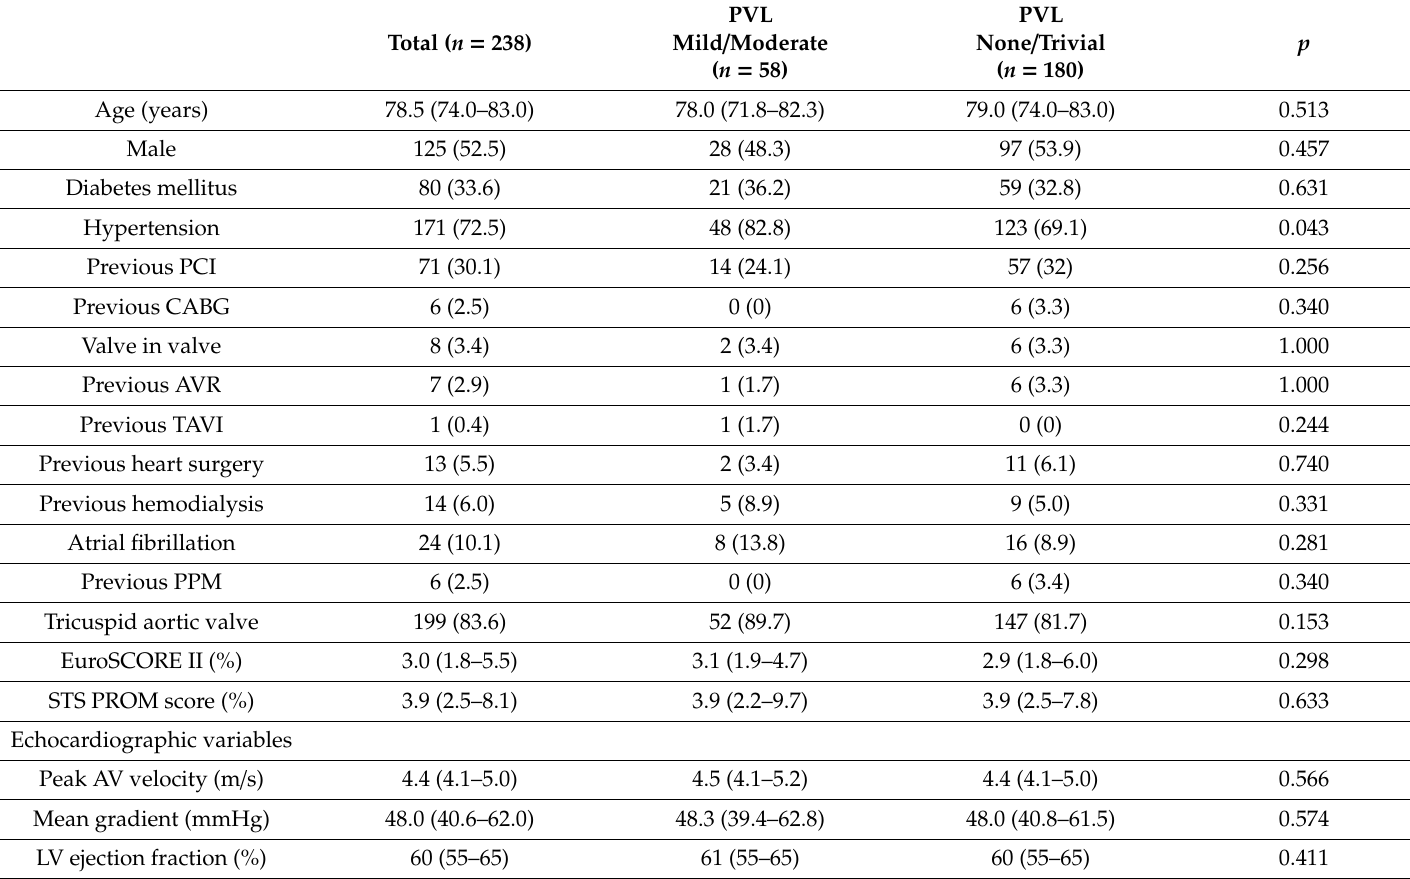
Table 1. Baseline Clinical and Procedural